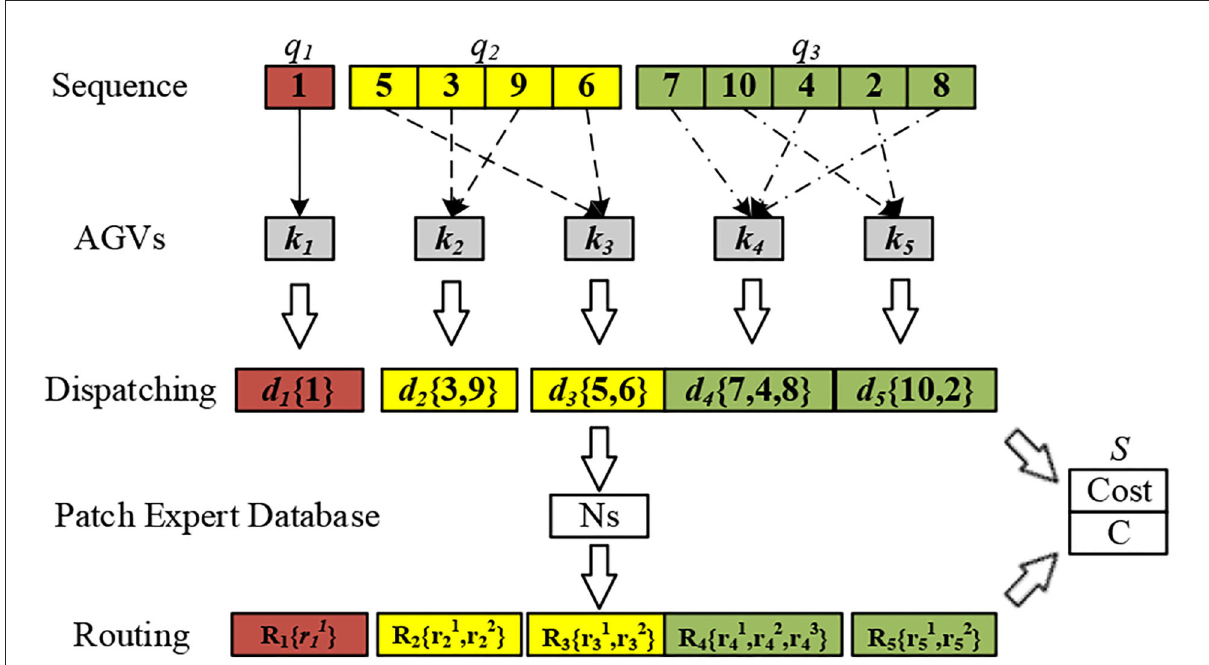
FIGURE3 A description of the integrated scheduling problem.